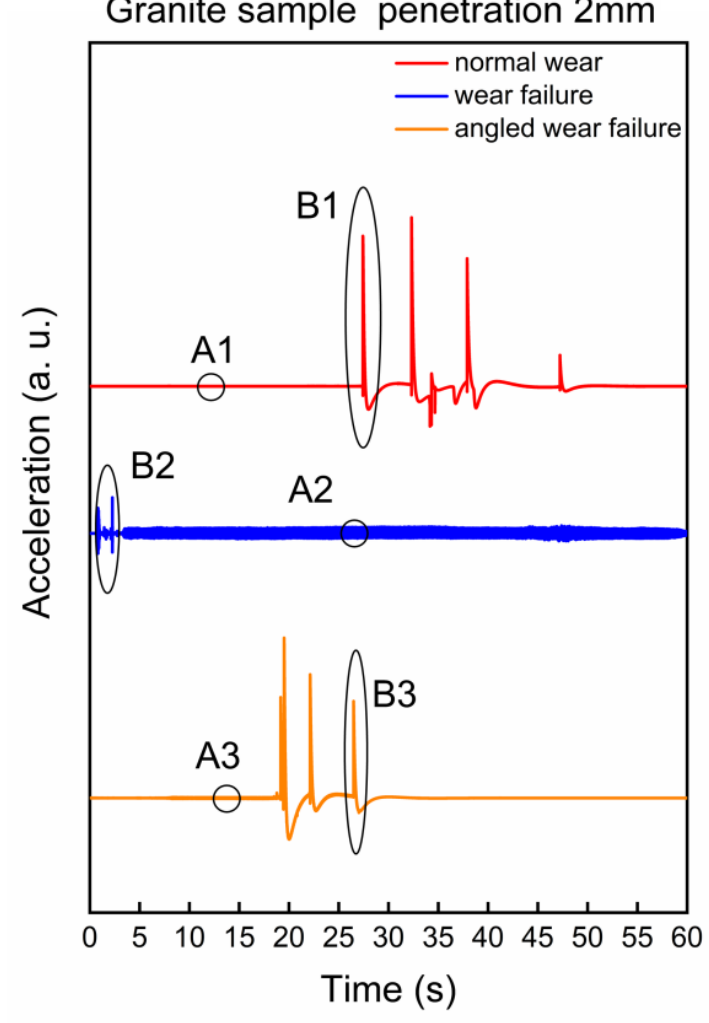
Figure 4. Granite sample, penetration 2 mm, 60 s time domain vibration waveforms of rock breaking process with different cutters.